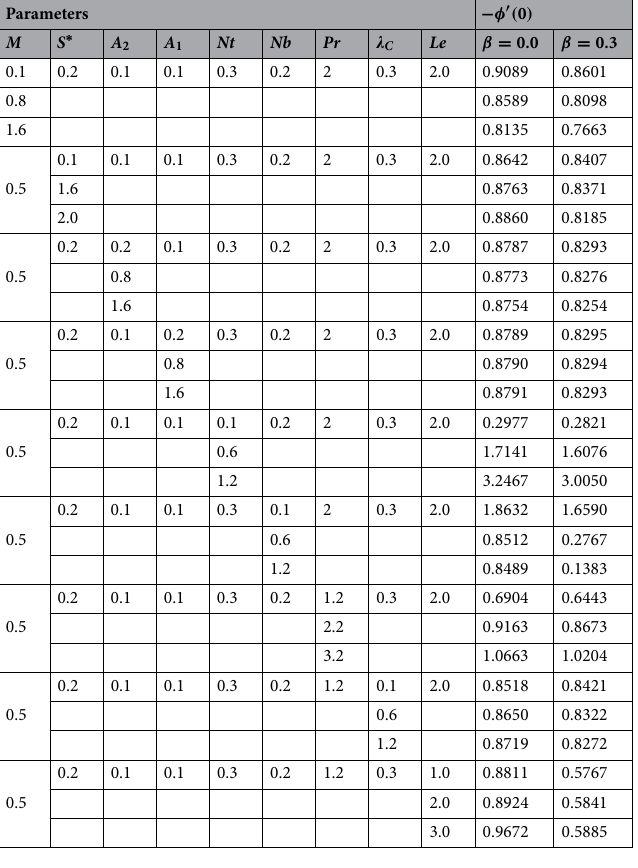
Table 4. Outcomes of − f ′′ ( 0 ) versus M , S ∗ , A 1 , A 2 , Nt , Nb , Pr , (cid:31) C and Le .